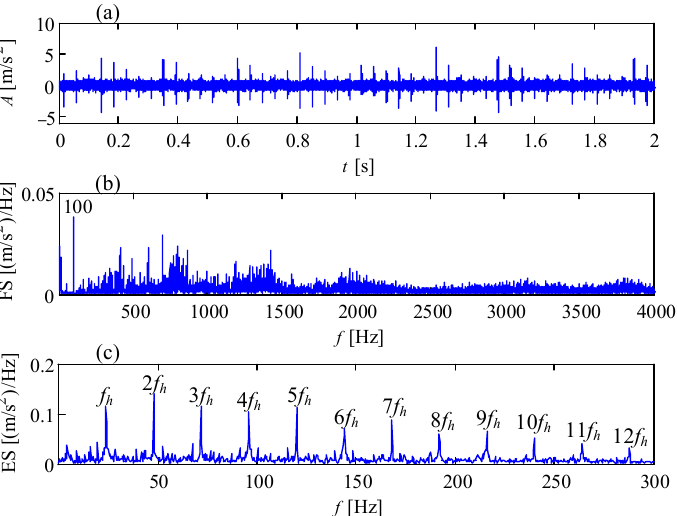
Figure 16. Vibration signal of generator bearing looseness at nondrive end: ( a ) temporal signal; ( b ) Fourier spectrum; ( c ) envelope spectrum.